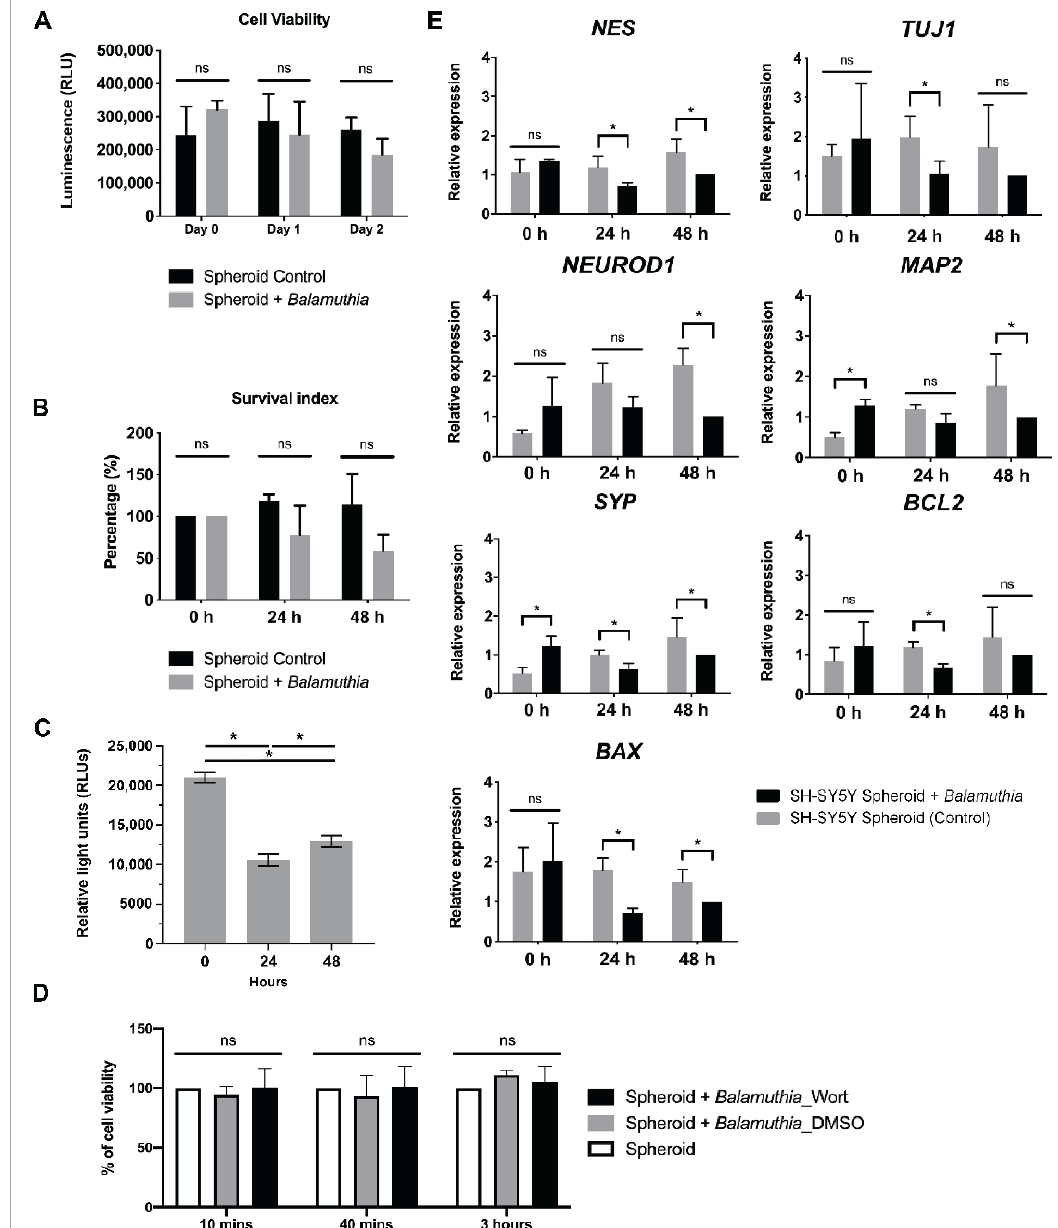
Figure 3. The effects of B. mandrillaris trophozoites on the neurospheroid. ( A ) Cell viability of the neurospheroid indicated by ATP level. ( B ) Survival index of the neurospheroid. The survival index was calculated based on the level of ATP at a given time point relative to that of the starting point (0 h). ( C ) The level of ATP produced by B. mandrillaris trophozoites in the feeder-free cultures. ( D ) Inhibition of trogocytosis using 20 nM Wortmannin, an inhibitor of phosphoinositide 3-kinases. ( E ) Semiquantitative PCR of neuron-specific and apoptosis-related genes. Bar graphs display data of the mean ± standard deviation calculated from technical triplicates. The data are representative of independent experiments ( n = 3). The statistical test: * p < 0.01; ns: not